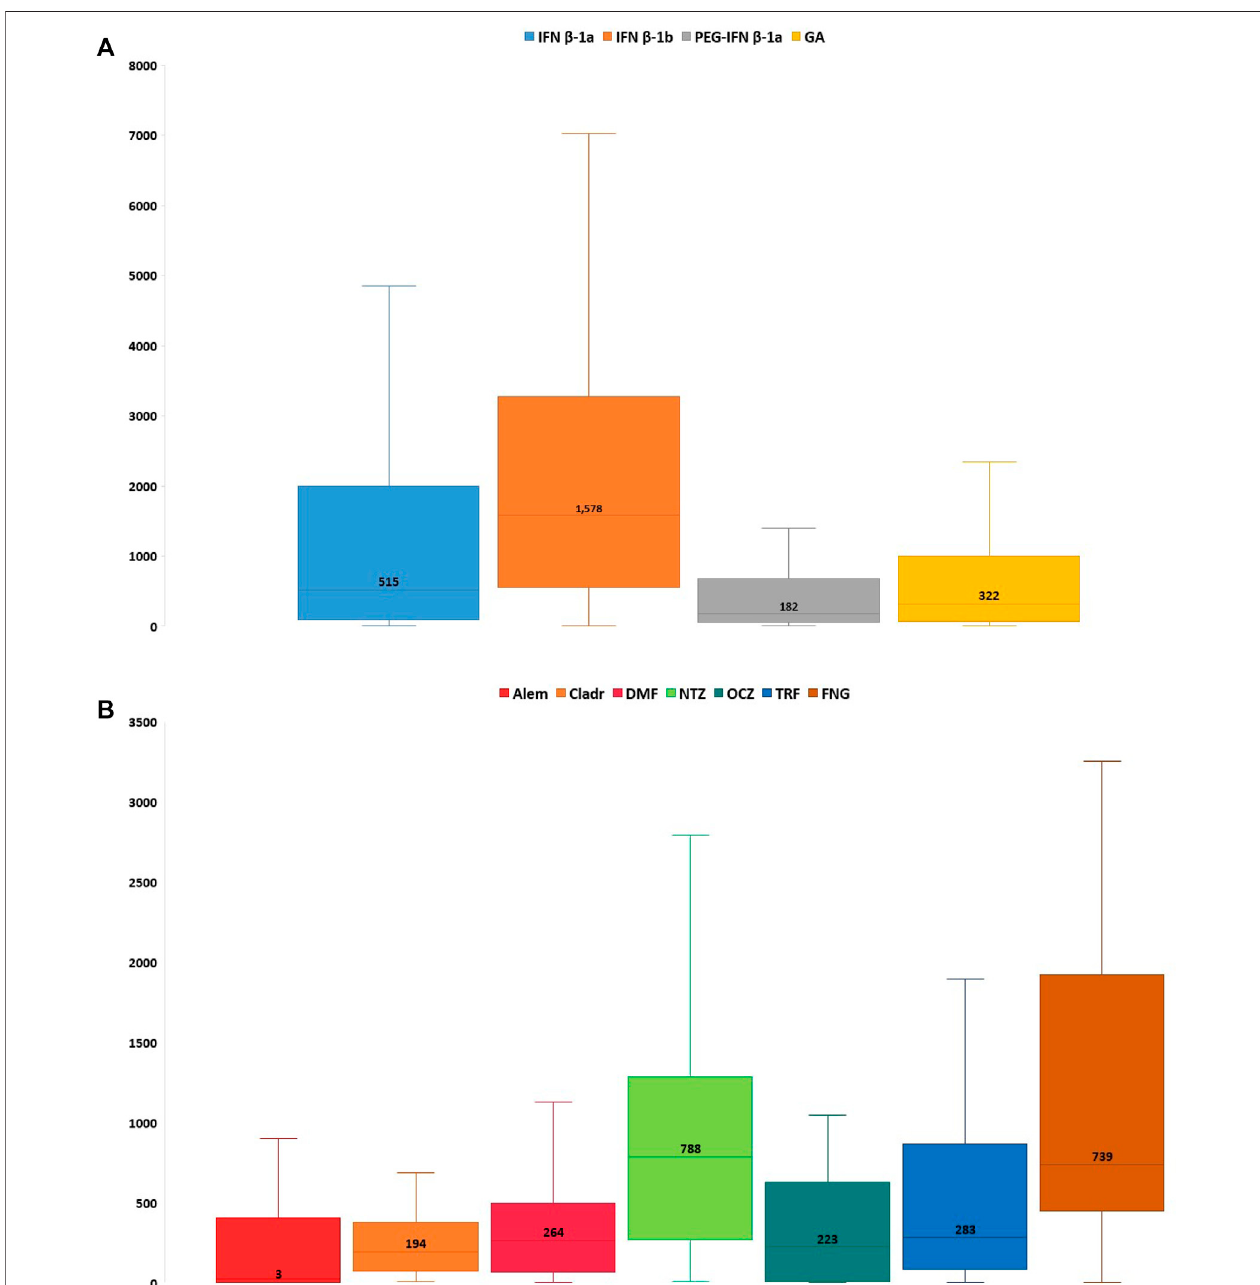
FIGURE 2 | Time to onset of Sicilian ADRs related to immunostimulants (A) and immunosuppressants (B) approved for MS. ADR, adverse drug reaction; Alem, alemtuzumab; Cladr, cladribine; DMF, dimethyl fumarate; FNG, fi ngolimod; GA, glatiramer acetate; IFN β -1a, interferon β -1a; IFN β -1b, interferon β -1b; MS, multiple sclerosis; NTZ, natalizumab; OCZ, ocrelizumab; PEG-IFN β -1a, peginterferon β -1a; TRF, teri fl